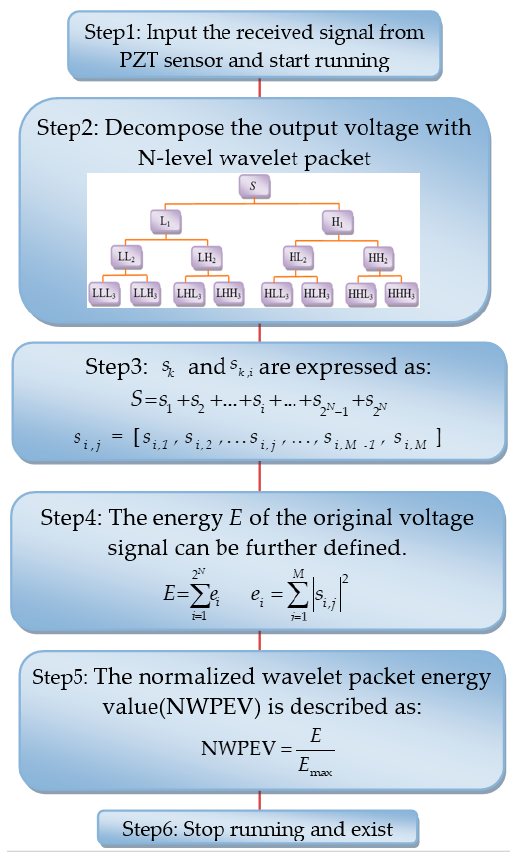
Figure 9. The flowchart of the determination of the normalized wavelet packet energy value (NWPEV).